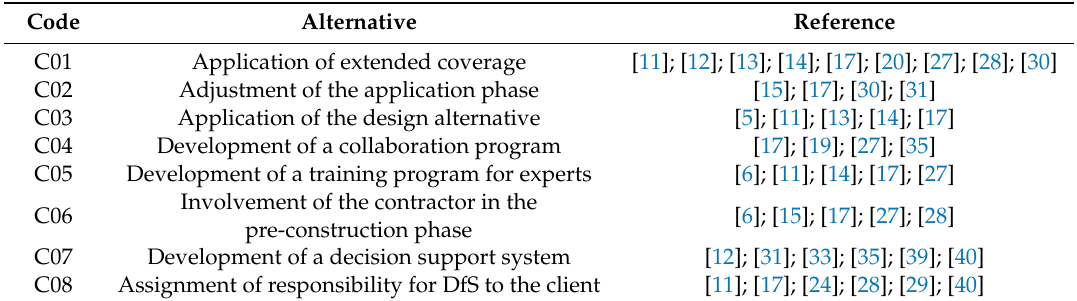
Table 1. Definitions of the Design for Safety (DfS) improvement